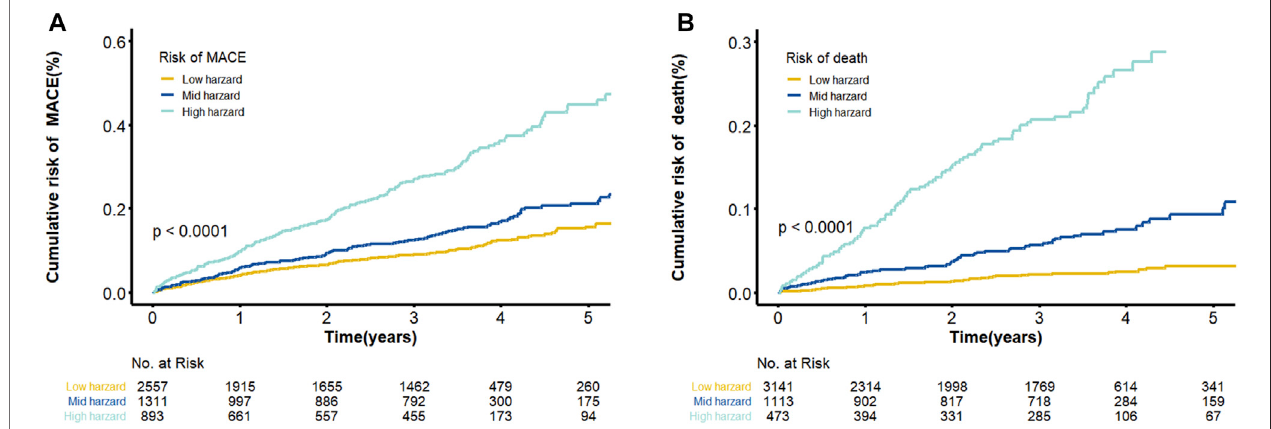
FIGURE 8 | Cumulative Kaplan – Meier curves of the prediction model. (A) Cumulative risk of MACE by predicted 5-years ABC-MACE risk group; (B) Cumulative probability of mortality by predicted 5-years ABC-death risk group. Note: Survival curves strati fi ed by the score calculated by the nomogram scoring system [low risk, moderate risk and high